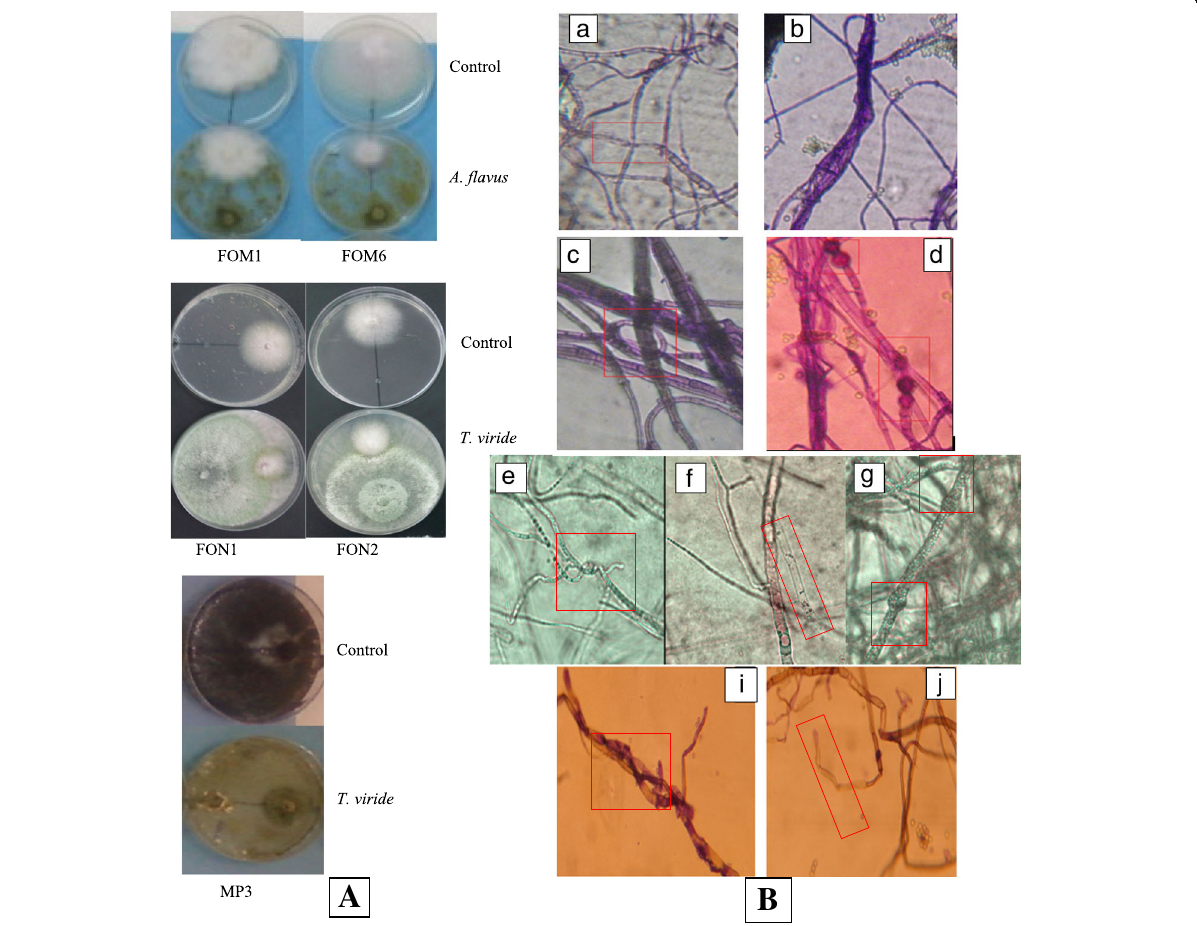
Fig. 1 a Dual confrontation between two F. o. melonis FOM isolates and A. flavus , two F. o. niveum FON isolates and T. viride , and M. phaseolina MP3 and T. viride . b Mycelial interaction in vitro between F. o. melonis FOM ( a, b, c, and d ) and A. flavus , F. o. niveum FON ( e, f, and g ) and T. viride , and M. phaseolina MP3 ( i and j ) and T. viride after 5 days of incubation in PDA at 28 °C (Gr ×40) (one plate per treatment was illustrated). Three plates/treatment were taken for microscopic examination of F. o. melonis and F. o. niveum cultures, revealing lysis of fungal mycelia ( a, f ), mycelia cords ( b ), mycelium winding ( c, e ), and chlamydospore formation ( d, g ). Concerning M. phaseolina : i penetration sites of the antagonist and j lysis of the pathogen